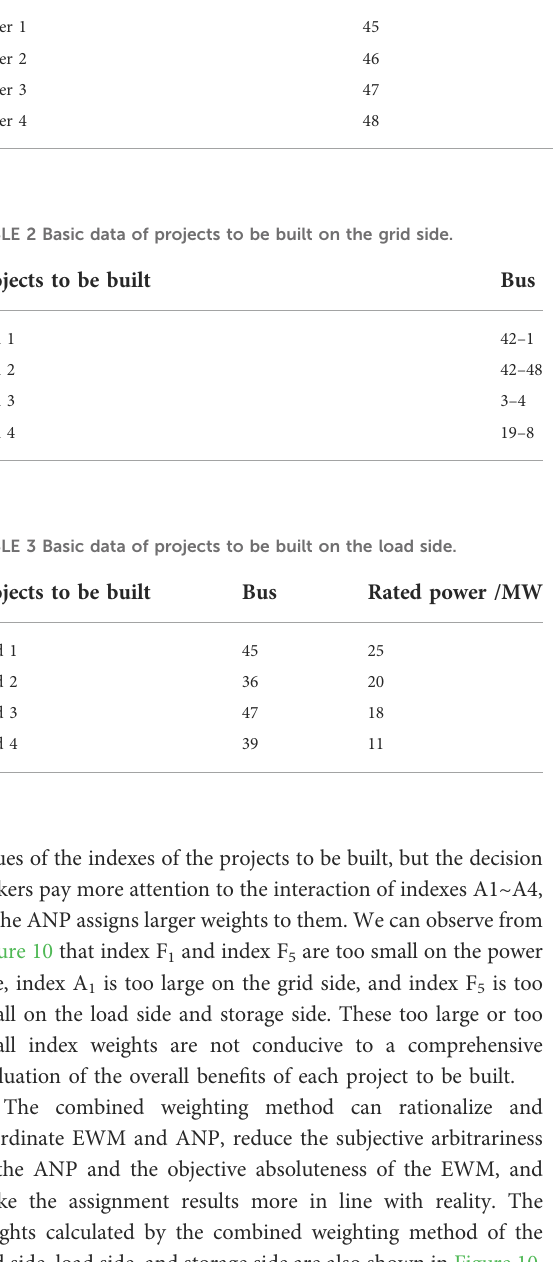
TABLE 1 Basic data of projects to be built on the power side. Projects to be built